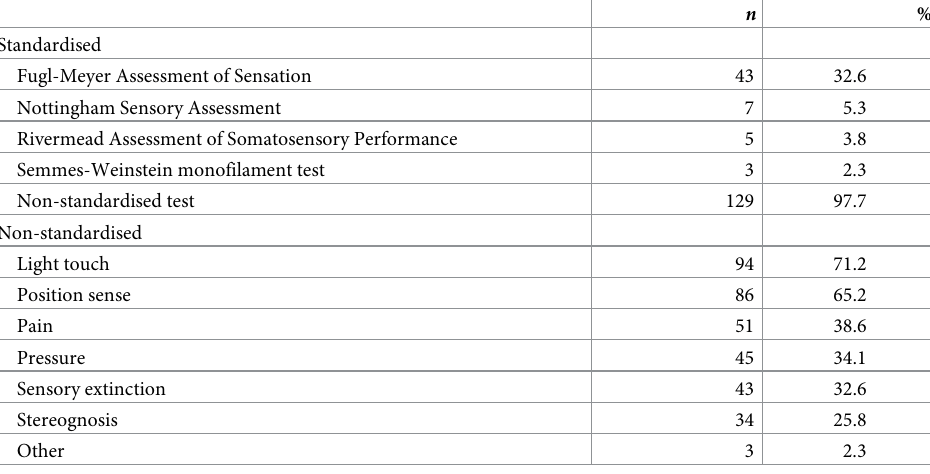
Table 2. Types of standardised and non-standardised assessment of somatosensation.